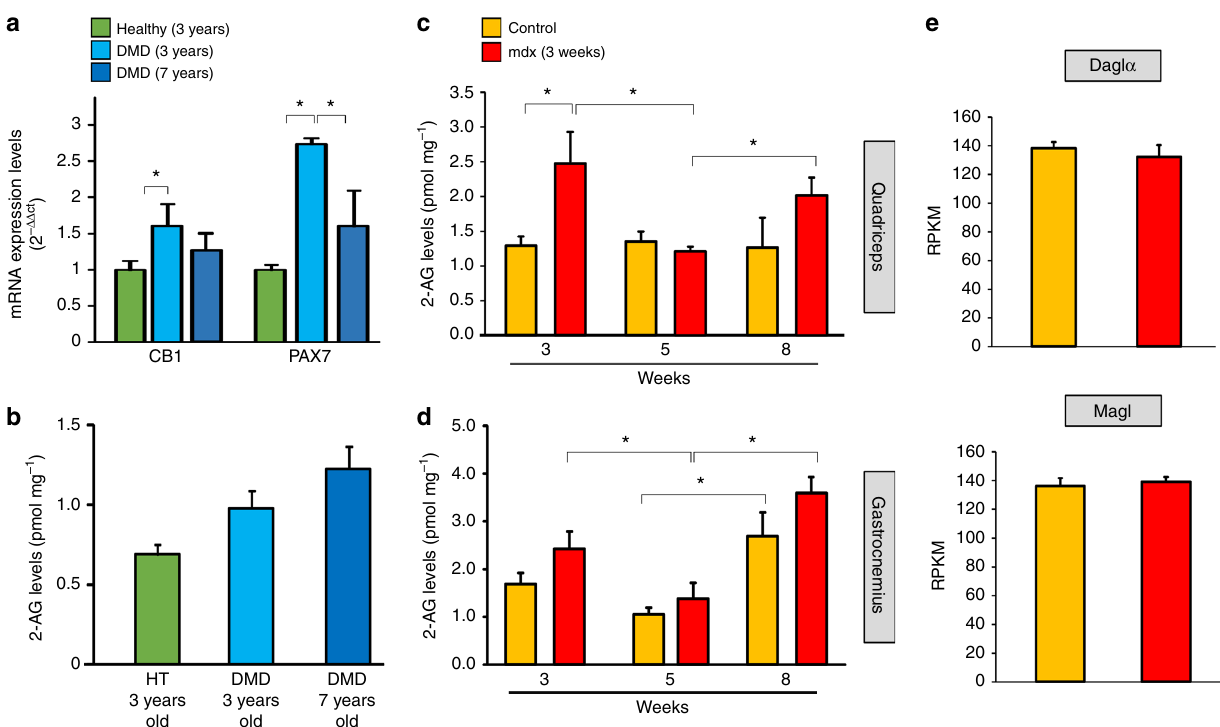
Fig. 2 CB1 and PAX7 expression and 2-AG levels in dystrophic muscles. a mRNA expression levels of CB1 and PAX7 in muscle samples of healthy children (HT, controls n = 3) or DMD donors of 3 ( n = 4) and 7 ( n = 4) years. b Measurement of the endogenous levels of 2-AG in muscle samples of the same healthy and DMD donors. Time course of the endogenous levels of 2-AG in the quadriceps ( c ) and gastrocnemius ( d ) muscle of control (dark yellow; n = 8) and mdx (red columns; n = 8) mice. The levels of 2-AG are expressed as pmol mg − 1 of wet tissue weight. * P ≤ 0.05 vs. control group, determined by Student ’ s t test. e The bar graphs show RPKM (Reads Per Kilobase of transcript per Million mapped reads) normalized values for the Dagl α and Magl